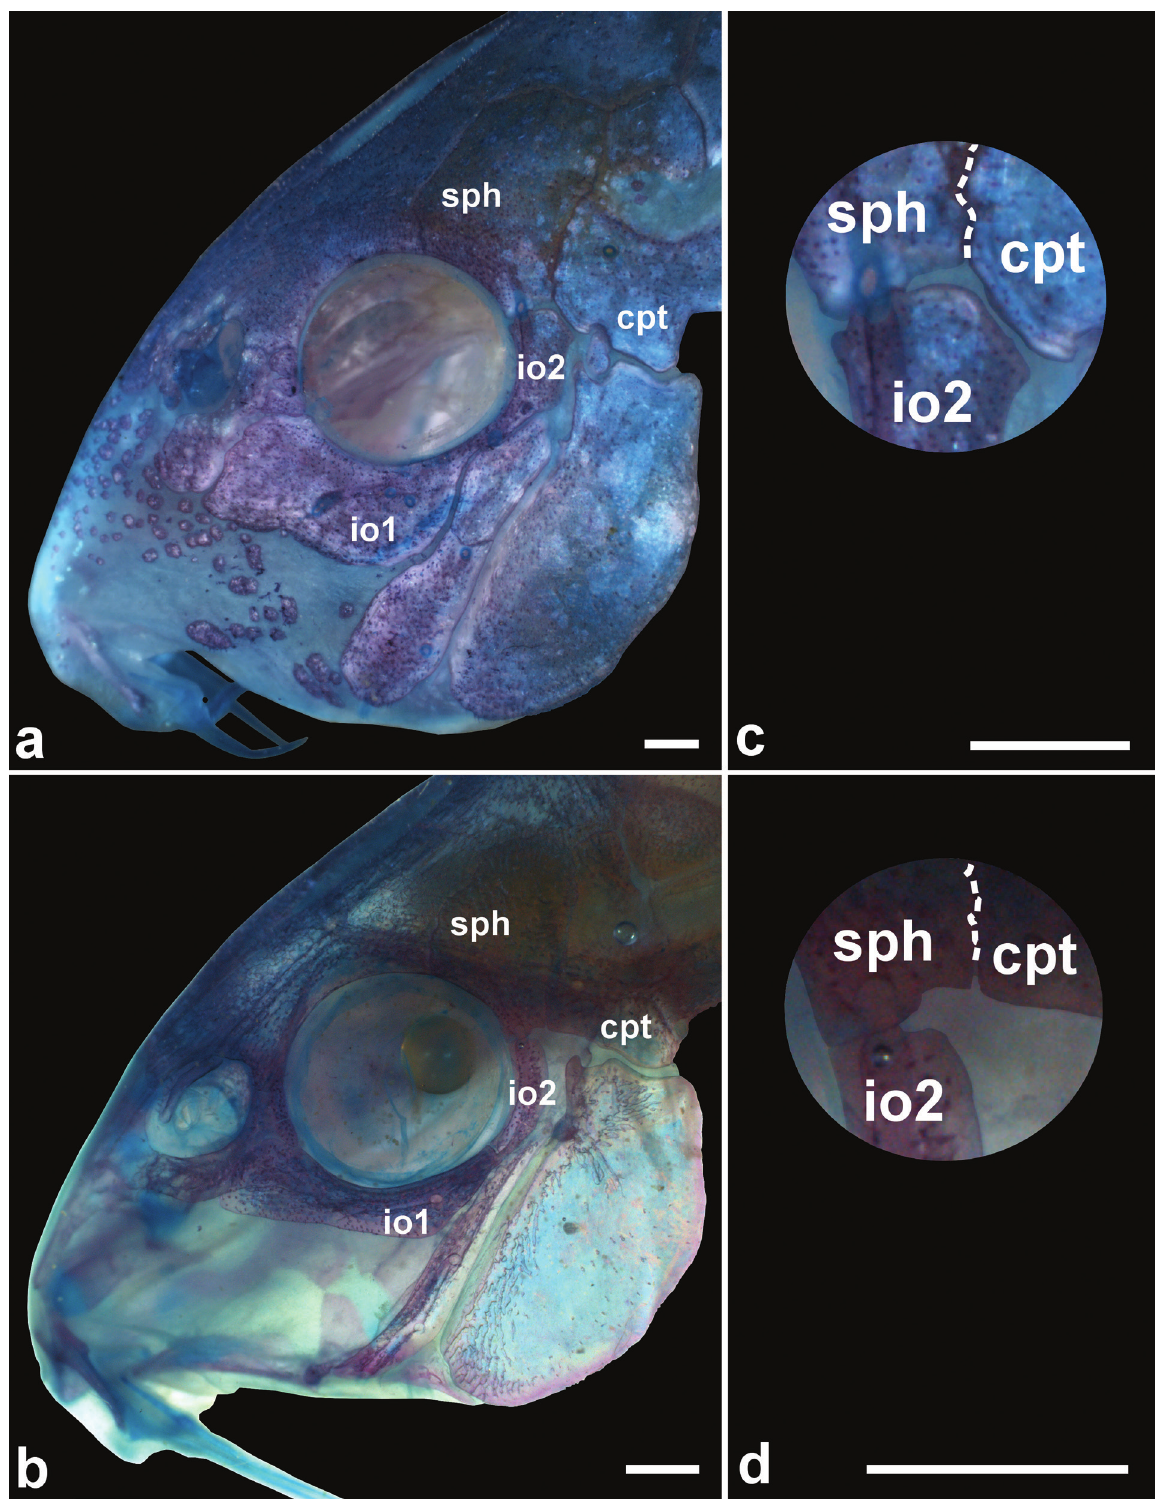
Fig. 2. Lateral view of the head of c&s specimens of (a, c) Corydoras eversi , paratype, NUP 17310, 42.5 mm SL, showing the well-developed ventral expansion of the infraorbital 1 and the platelets on the snout (a) and infraorbital 2 in contact with compound pterotic (c); and (b, d) Corydoras araguaiaensis , MZUSP 87155, 31.8 mm SL, showing the moderately-developed ventral expansion of the infraorbital 1 (b) and infraorbital 2 not in contact with compound pterotic (d). The dotted lines in (c) and (d) represent the suture between sphenotic and compound pterotic. Abbreviations: io1: infraorbital 1, io2: infraorbital 2, sph: sphenotic, cpt: compound pterotic. Scale bar = 1.0